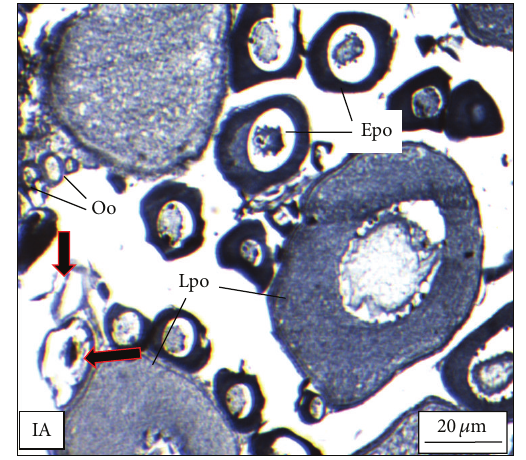
Figure 11: The histological section of the ovary of a M. tengara during the late spawning phase (August) showing all of the previtel- logenic oocyticstages[Oo:oogonia, Epo: early perinucleolar oocyte, and Lpo: late perinucleolar oocyte] with few apoptotic follicles (af) that are gradually merging with the ovarian stroma when the tissues are treated with ZnS nanoparticles at the concentration of 500 𝜇 g/L [IA: Iron-Alum